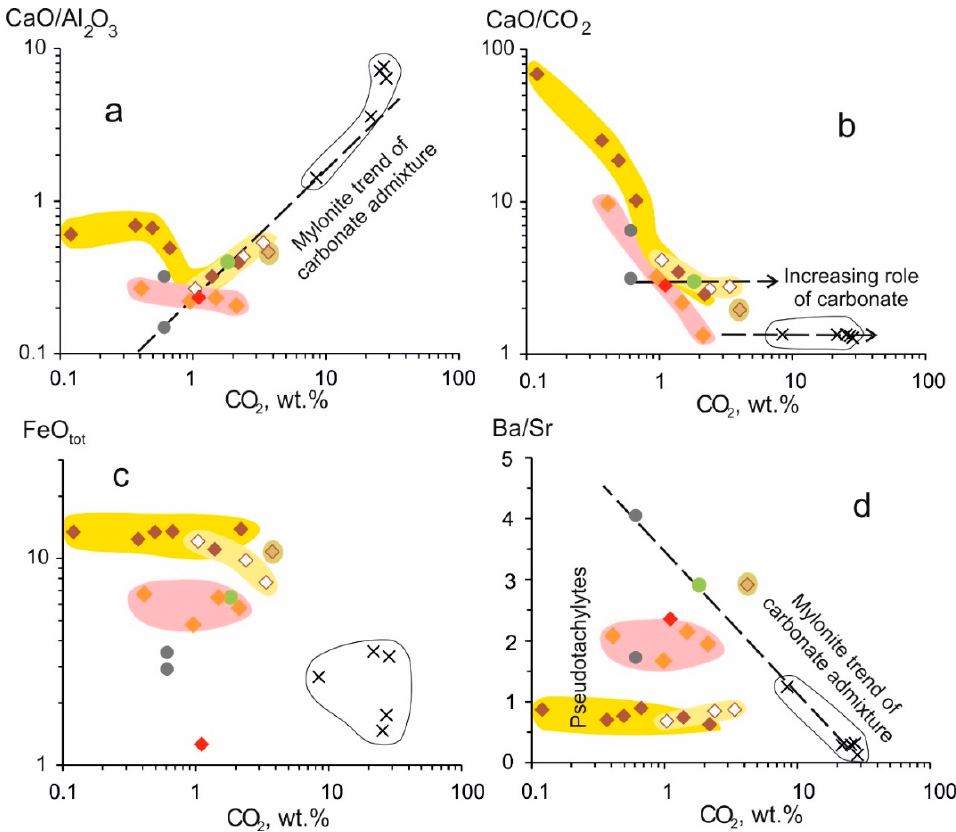
Figure 8. Pseudotachylytes, mylonites, and epidote-chlorite rock from the MSF on diagrams of CO 2 plotted versus: ( a ) CaO/Al 2 O 3 , ( b ) CaO/CO 2 , ( c ) FeO tot , and ( d ) Ba/Sr. In diagrams, measured major oxide values are used. Symbols are as in Figure 4.